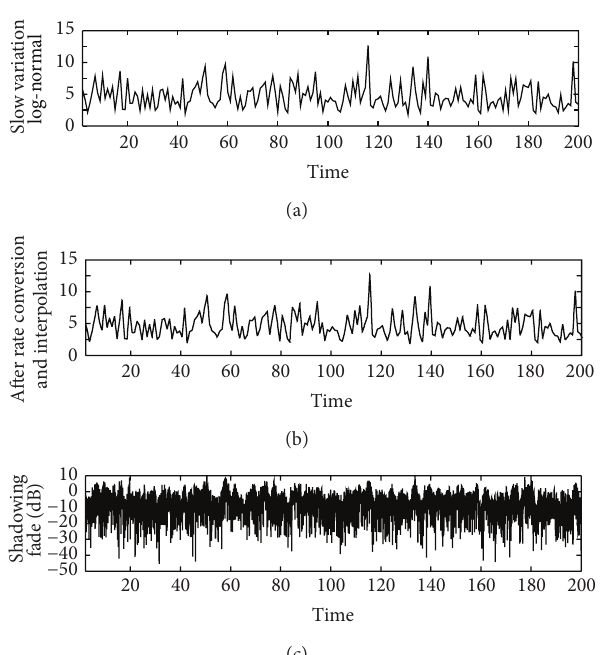
Figure 9: Received SNR in clear LOS state: (a) CDF and (b) PDF.